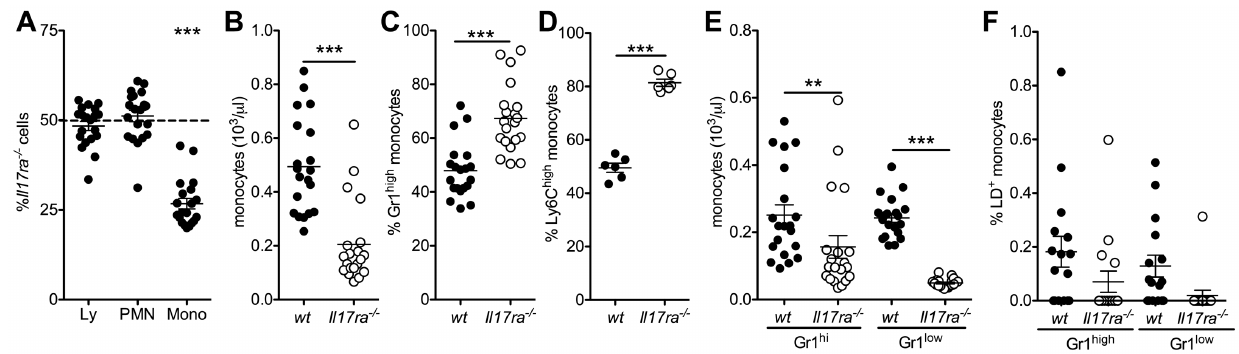
Figure 3. Absence of IL-17 receptor A reduces monocyte counts in a cell specific manner. Leukocyte analysis in mixed bone marrow chimeric wt (CD45.1)/ Il17ra -/- (CD45.2) mice. ( A ) The proportion of Il17ra -/- cells among blood lymphocytes (Ly), granulocytes (PMN) and monocytes (mono). ( B ) Absolute monocyte concentrations for each genotype. ( C,D ) The proportion of Gr1 high (C, n=20 mice from 3 independent transplantations) and Ly6C high monocytes (D, n=6) was significantly higher among Il17ra -/- than wt cells. ( E ) Absolute blood monocyte concentrations (Bonferroni after One-way-ANOVA, n=20 mice from 3 independent transplantations). ( F ) Proportion of blood monocytes staining as dead cells (n=16 from 3 independent transplantations, Bonferroni after One-way-ANOVA)).